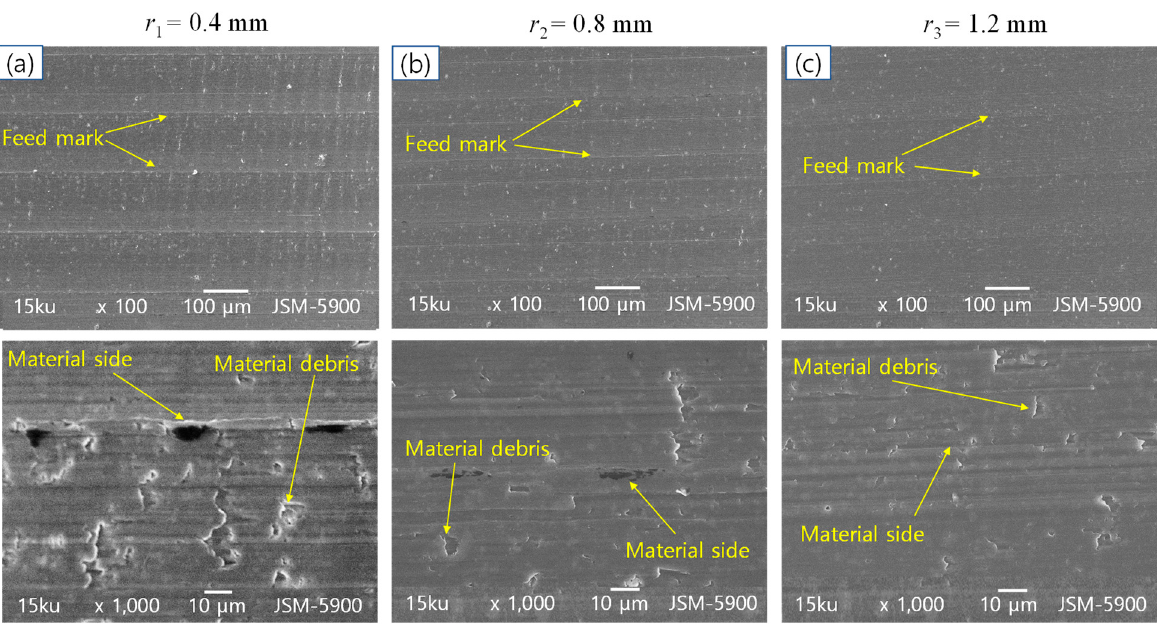
Figure 7. Micro-image of machined surface for feed rates of ( a ) 0.052, ( b ) 0.105 and ( c ) 0.209 mm/rev at 100× and 1000× magnifications (SEM) with a combination of cutting parameters r 1 and 710 rpm.